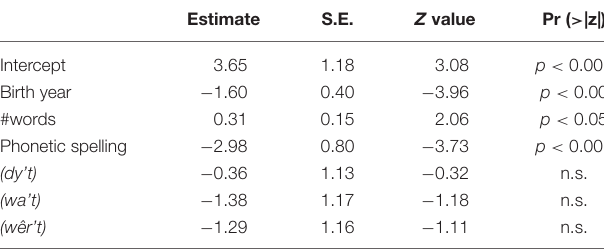
TABLE 7 | Optimal model for substitution of Frisian relative pronouns dy’t , dêr’t , wêr’t, and wa’t in Twitter data for FreqvarL, Twitterers who infrequently produced the variable (range = 1–21) in their tweets ( n = 818, N = 118). Estimate